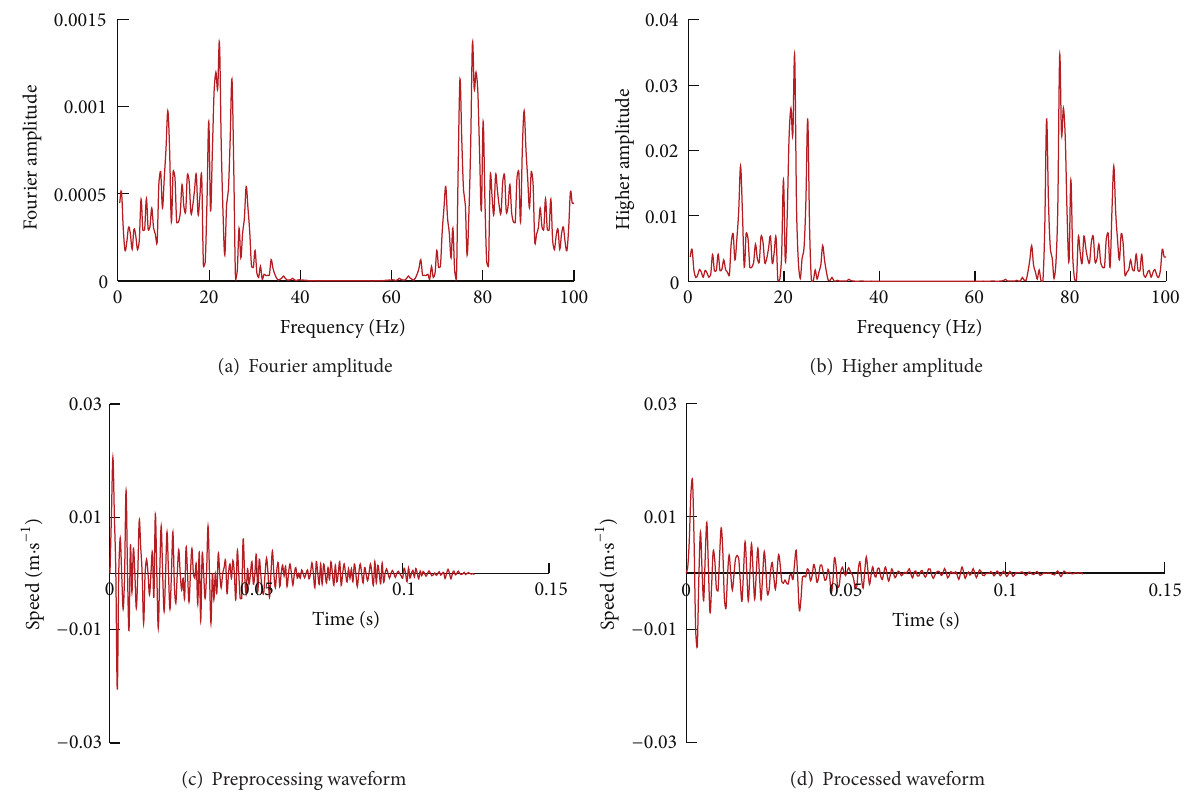
Figure 4: Filtering and baseline correction of the impulse wave